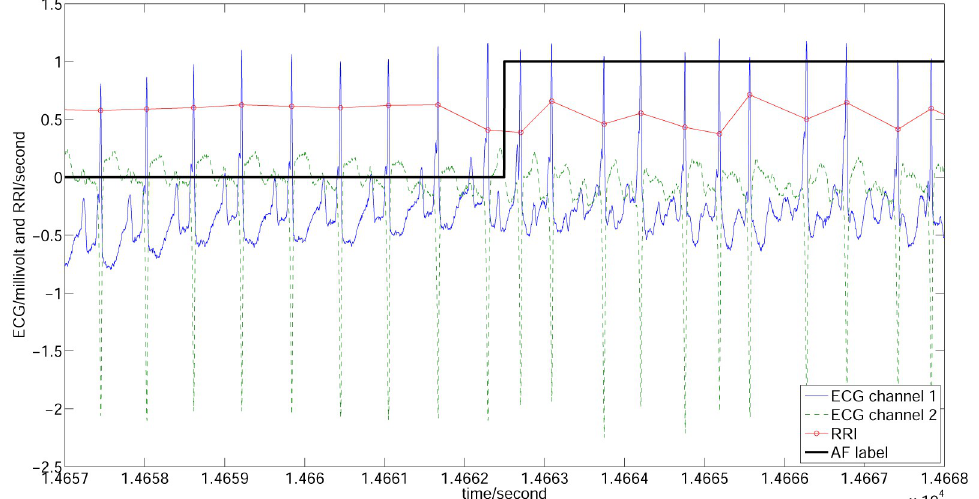
Fig 1. Demonstration of signals and annotations of AFDB (record 04043). Blue solid and green dashed lines indicate the ECG signals of two channels, red circled line is the RRI, and black thick line is the AF label (1 and 0 indicate AF and normal, respectively). It can be easily observed that the RRIs of AF and non-AF segments exhibit different patterns.